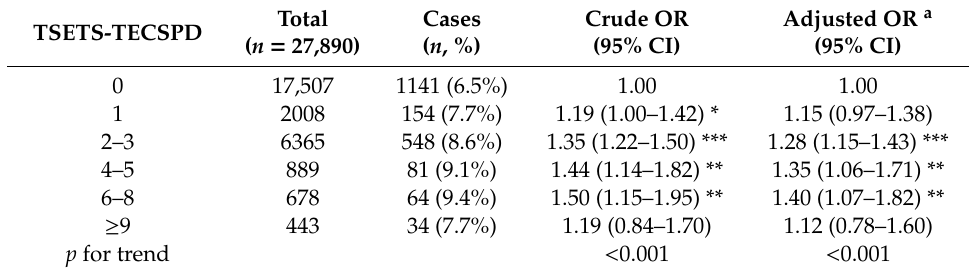
Table 3. The dose-response relationship between the total score of environmental exposure to tobacco smoke based on the time of exposing cigarettes smoked per day (TSETS-TECSPD) and astigmatism. Total TSETS-TECSPD ( n = 27,890)